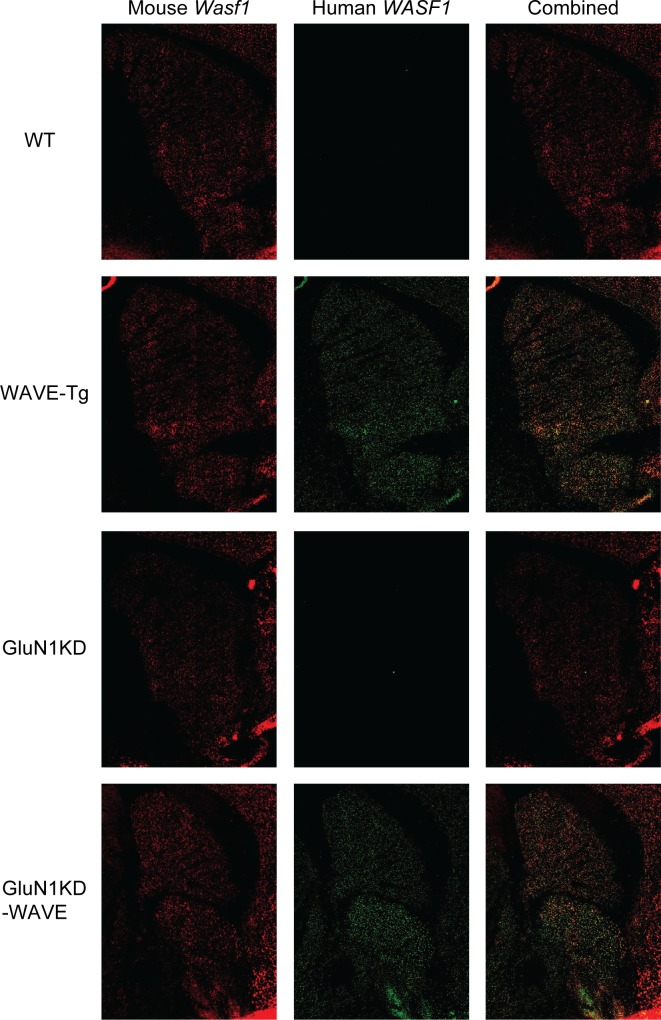
Fluorescent in situ hybridization of male WT, WAVE-Tg, GluN1KD, and GluN1KD-WAVE striatum.Endogenous, mouse Wasf1 message is shown in red (left column) while transgenic, human WASF1 is shown in green (middle column). Human WASF1 was expressed abundantly and specifically in transgenic mice with a pattern of expression similar to mouse Wasf1.